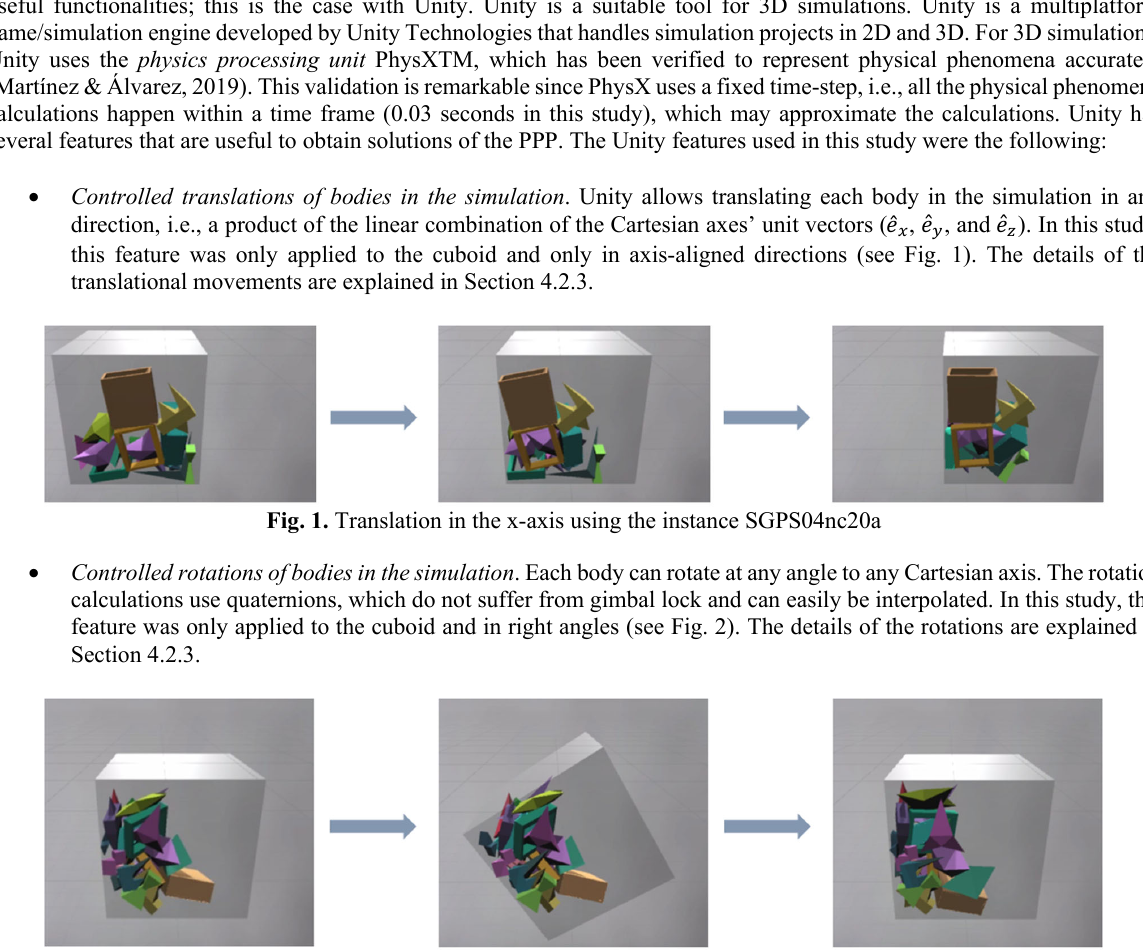
Fig. 2. Rotation in the 𝑒̂